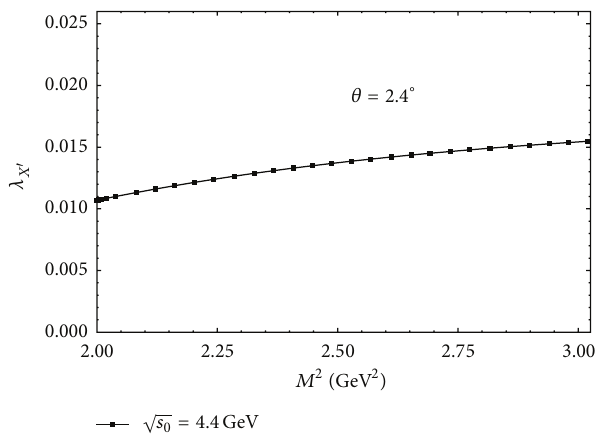
Figure 2: The dependence of the residue of the 𝑋 󸀠 state on Borel mass square 𝑀 2 for the mixing angle 𝜃 = 2.4 0 , at the fixed value of the continuum threshold √𝑠 0 = 4.4